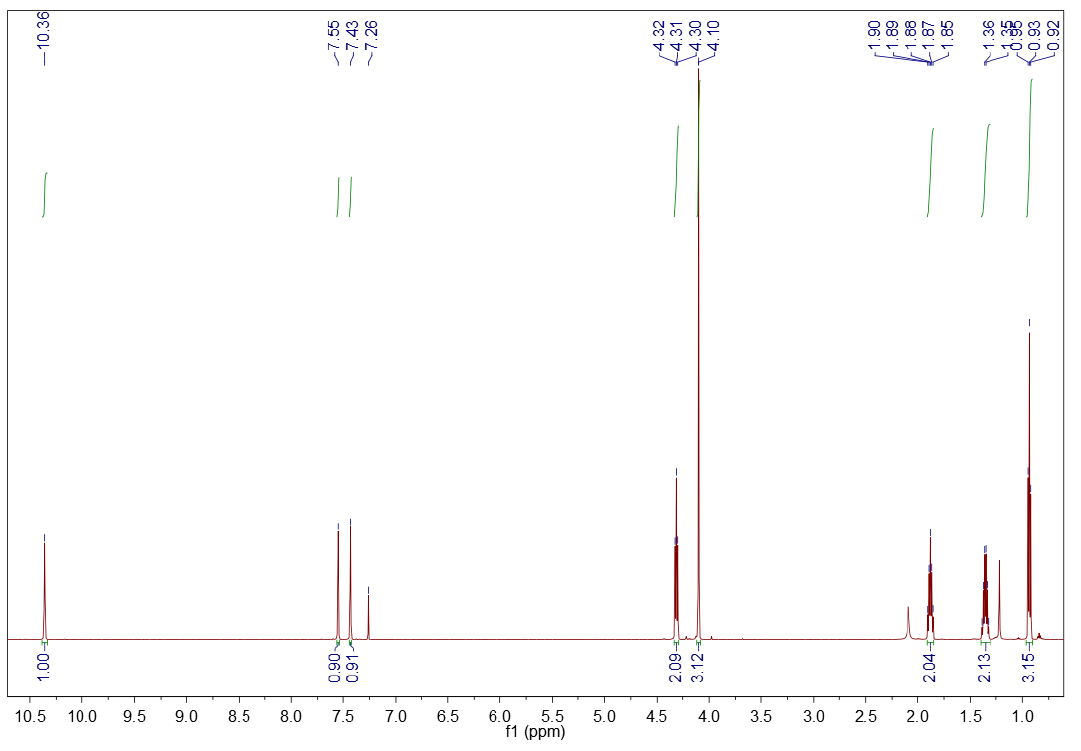
Figure 14. 1 H NMR spectrum of the recycled [BMIM][Br]. Sample of 10 mg in 0.7 mL deuterated chloroform, 600 MHz.